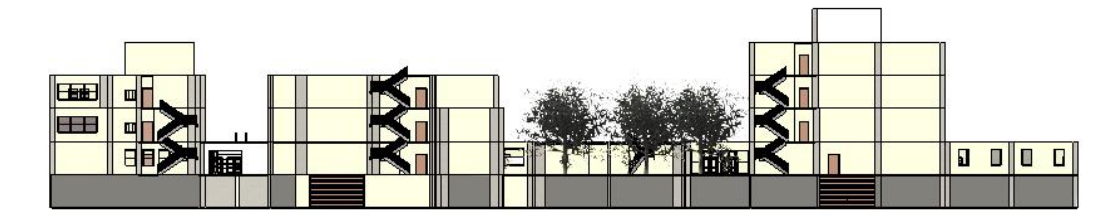
Figure 6. East view of the building.